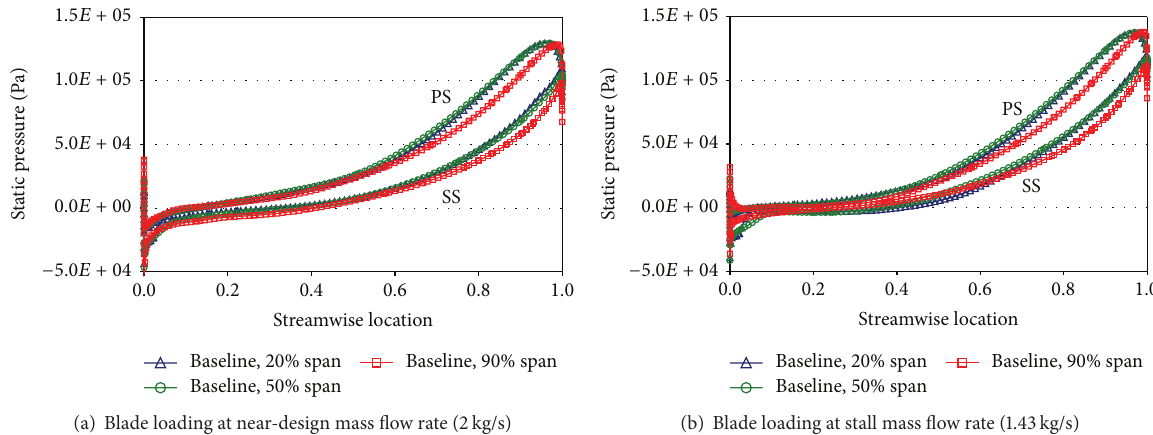
Figure 14: Impeller blade loading at three spanwise locations of 20%, 50%, and 90% from hub wall at near-design and stall mass flow rate.